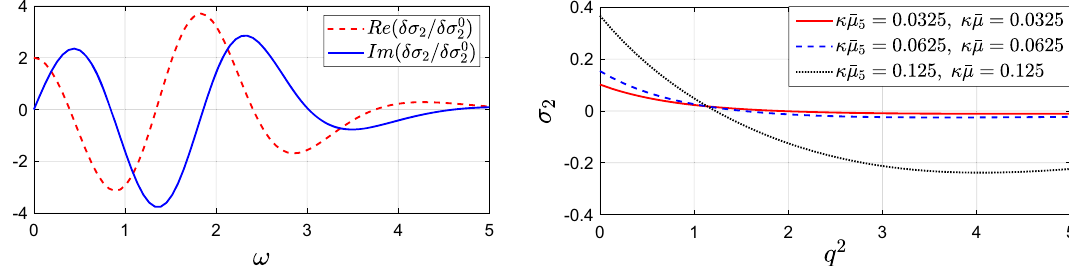
Fig. 17 ω -dependence of δσ 2 /δσ 0